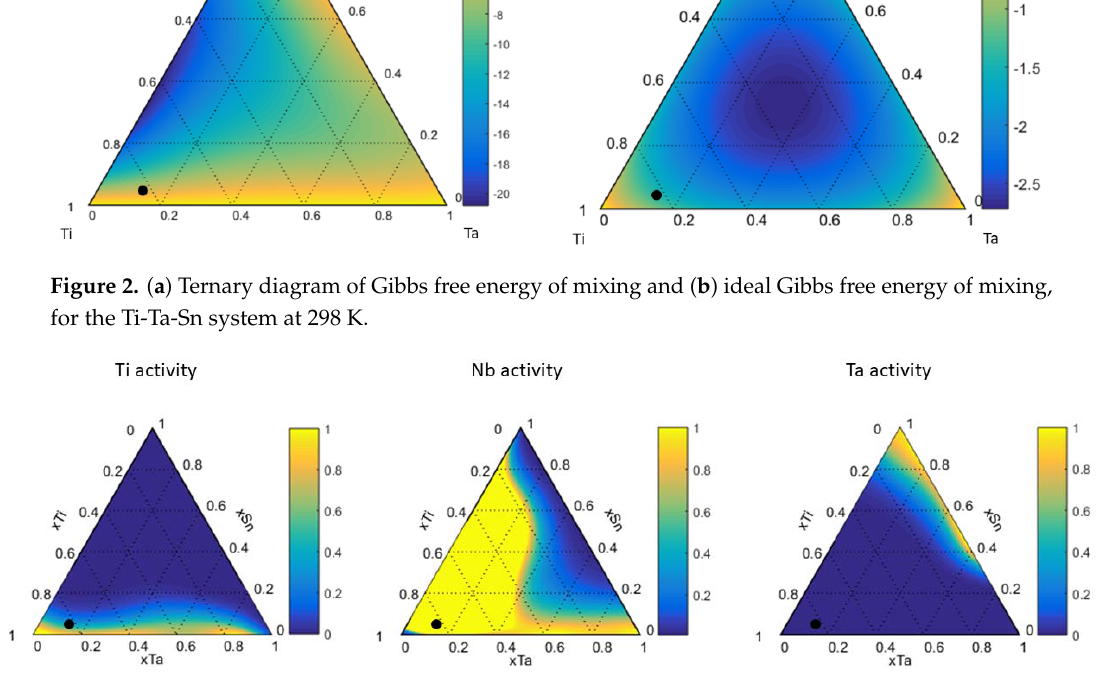
Figure 3. Activity changes as a function of composition for the formation of a solid solution in the Ti ‐ Nb ‐ Sn ternary systems at 298 K.